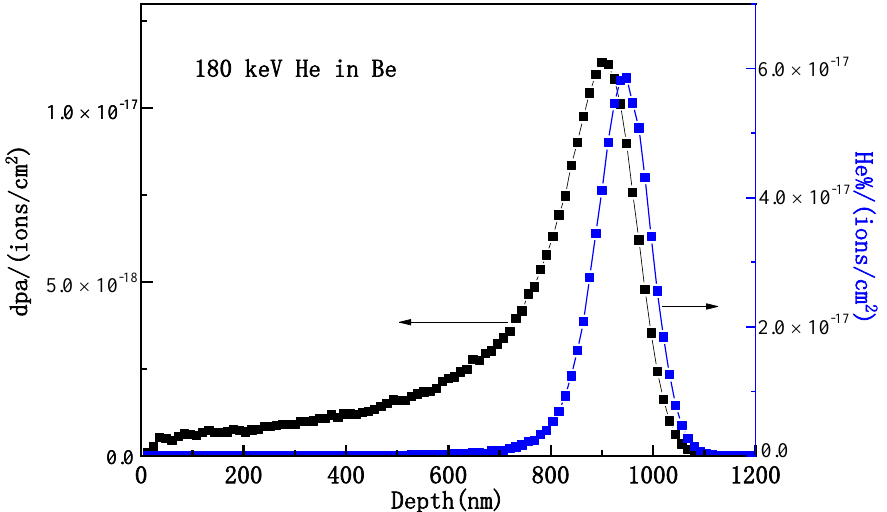
Figure 1. Cross section of dpa and helium concentration in beryllium with 180 keV helium ions calculated by SRIM. Table 2. Peak dpa and helium concentration for the specimen with different fluences.